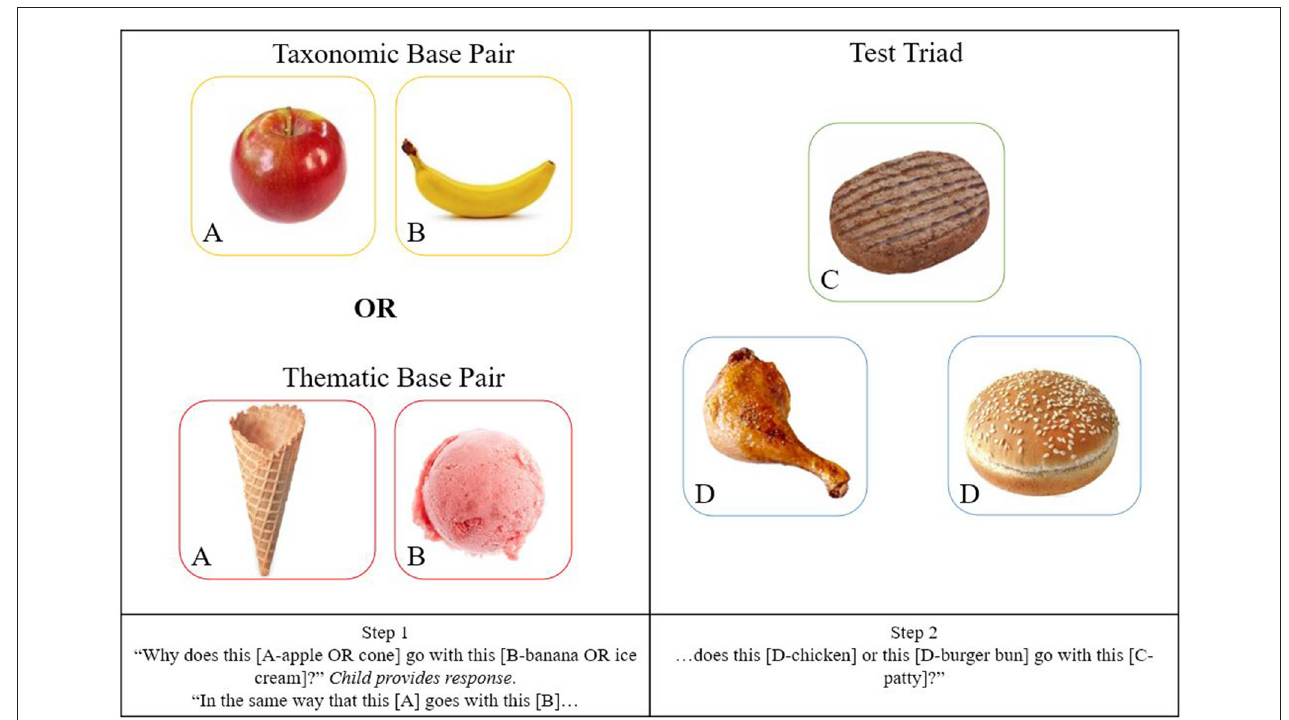
FIGURE 1 | Example of stimuli presented for both taxonomic and thematic analogy condition and example test triad.